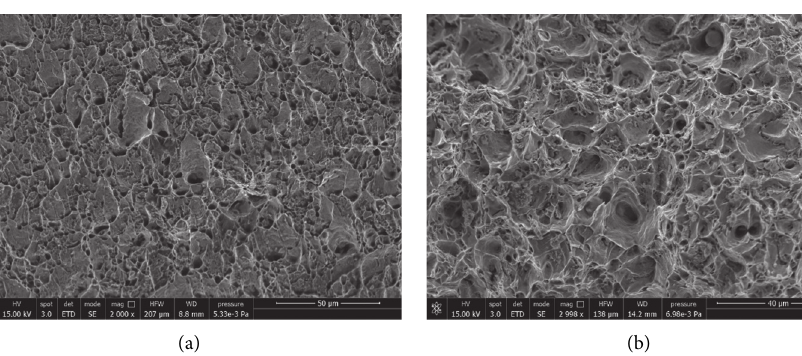
Figure 13: (a) TempCore ® B450C steel: ductile microstructure; (b) S355J0 micro-alloyed rebar: ductile microstructure.